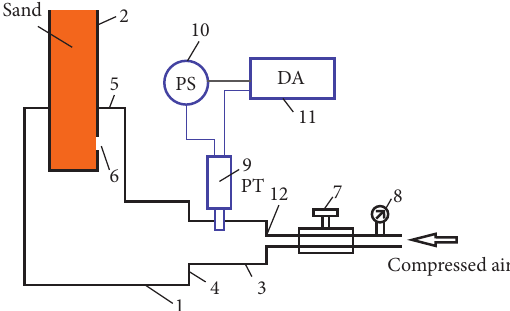
Figure 1: Schematic layout for measuring the sand collapse pressure. PT, pressure transducer; DA, data acquisition system; PS, power